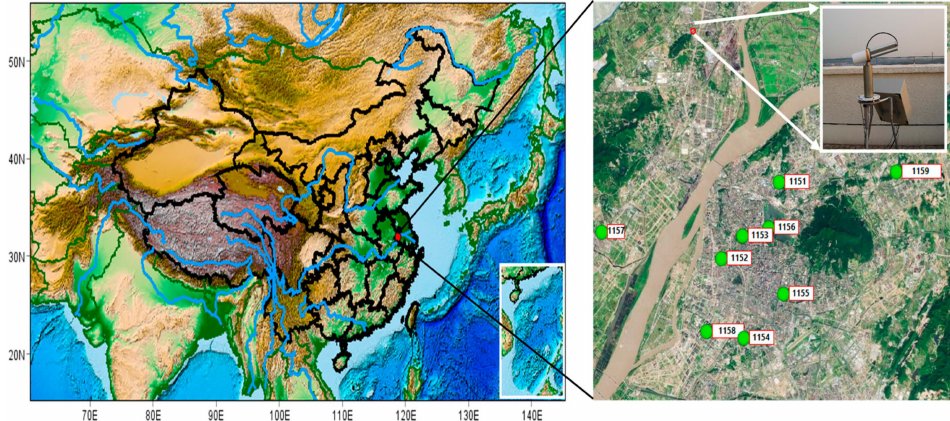
Figure 1. Location of Nanjing in the Jiangsu Province overlaid on a map created with the Global Relief Model. The zoom on the right shows the city of Nanjing along the Yangtze River, the location of